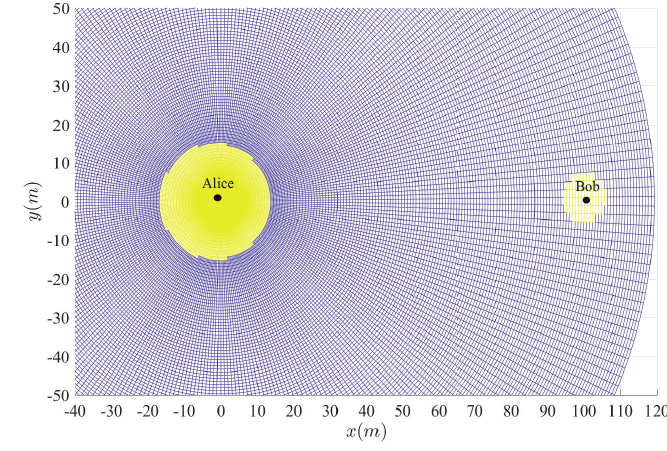
Figure 3. Insecure region with P th e = 15 dBm, N a = 4 and ρ = 10 − 8 .